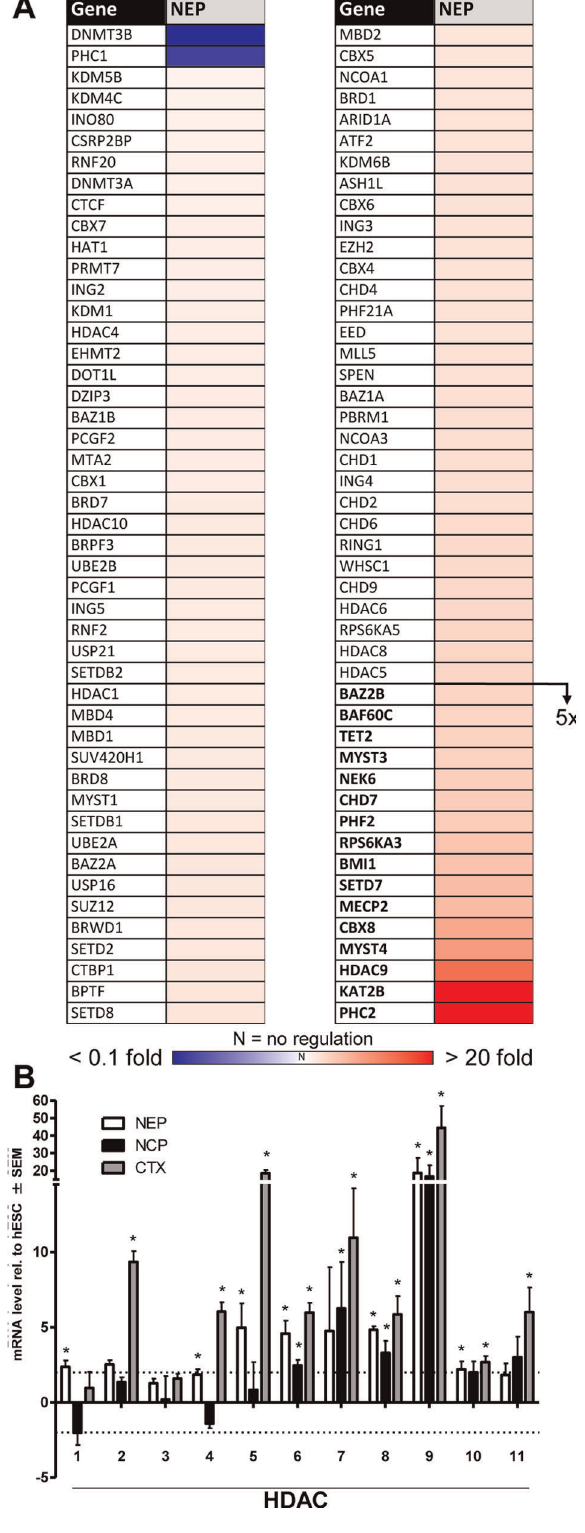
Figure 3. Transcriptional regulation of epigenetic modifiers during neuroepithelial differentiation. (A) The levels of epigenetic modifier transcripts of NEP and hESC were analyzed by qPCR in three independent cell preparations, and relative abundances were calculat- ed. The data were color-coded, with up-regulated genes displayed in